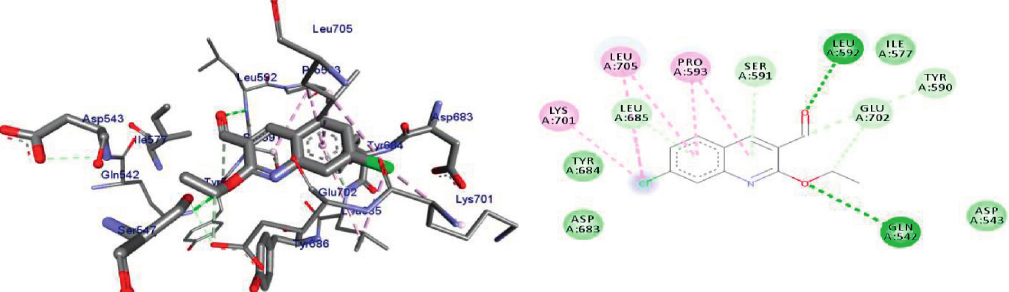
Figure 9: The binding interactions of compound 8 against human topoisomerase II α (PDB ID: 4fm9).